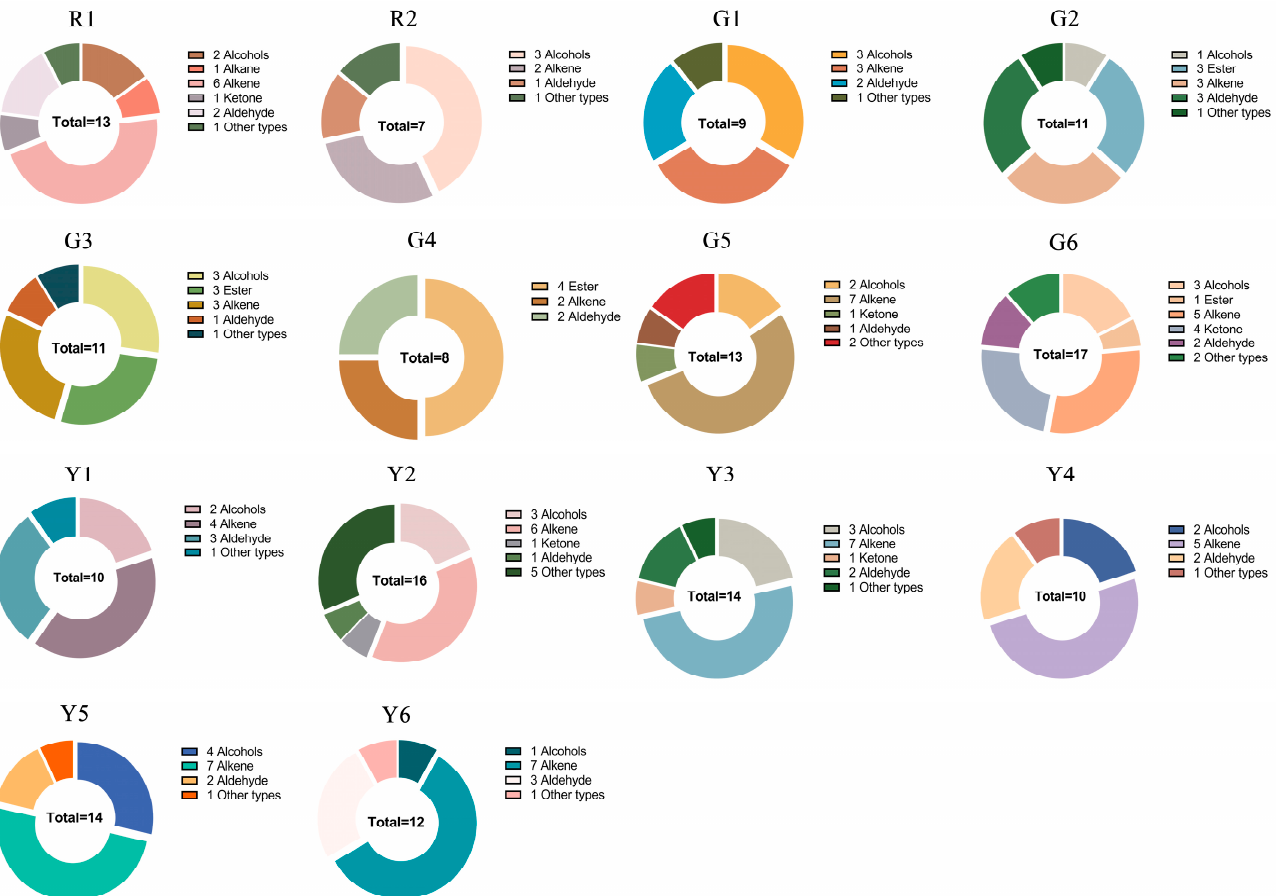
Figure 5. The content of aroma substances. ‘R1’, ‘Hongyang’. ‘R2’, ‘Donghong’. ‘G1’, ‘Cuiyu’.